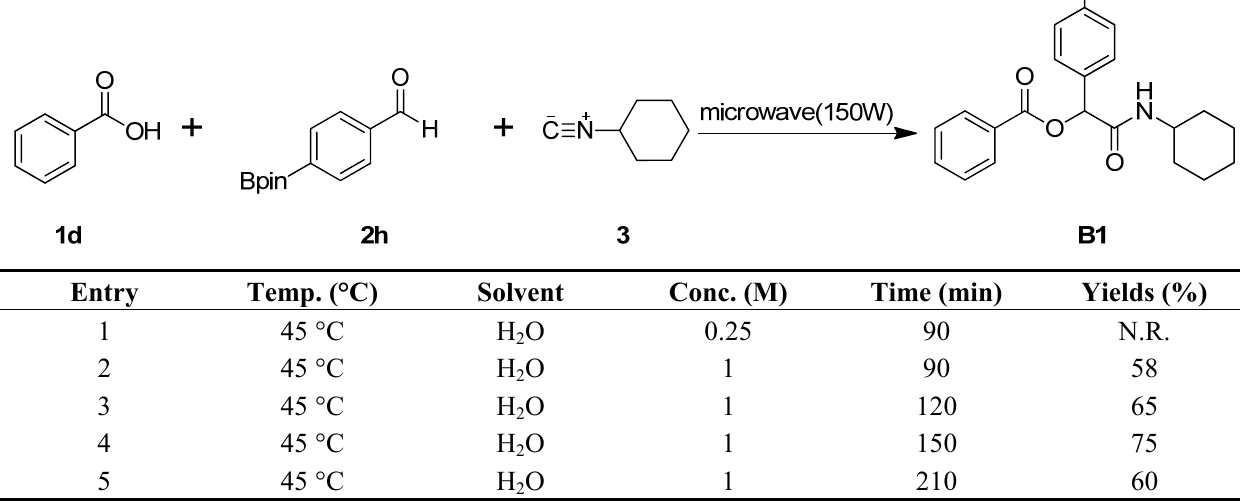
Table 3. Optimisation of Passerini reaction using boron-containing aldehyde building